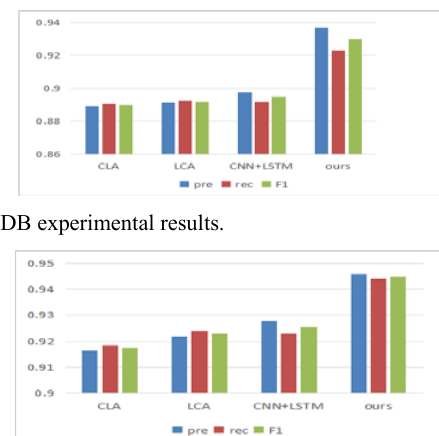
Fig. 5. THUCNews data set.